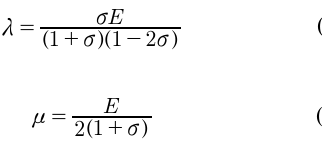
Table 3. The bulk modulus ( B , in GPa), shear modulus ( G , in GPa), Yong’s modulus ( E , in GPa),poisson’s ratio ( σ , in GPa), the first order Lame constant ( λ , in GPa), the second Lame constant ( µ , in GPa) and the Vickers hardness ( H